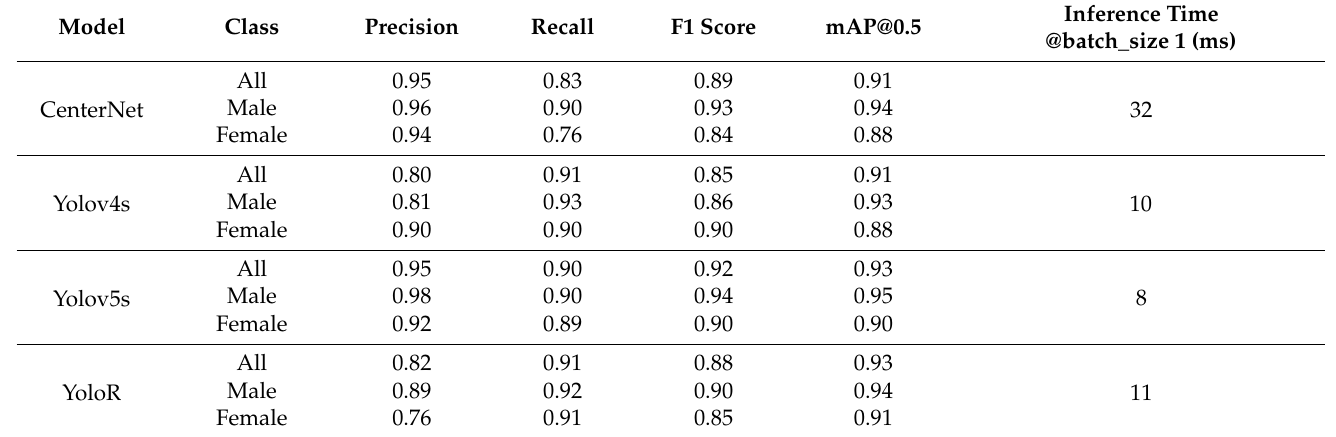
Table 1. Comparison of object detectors in a single-head dataset.